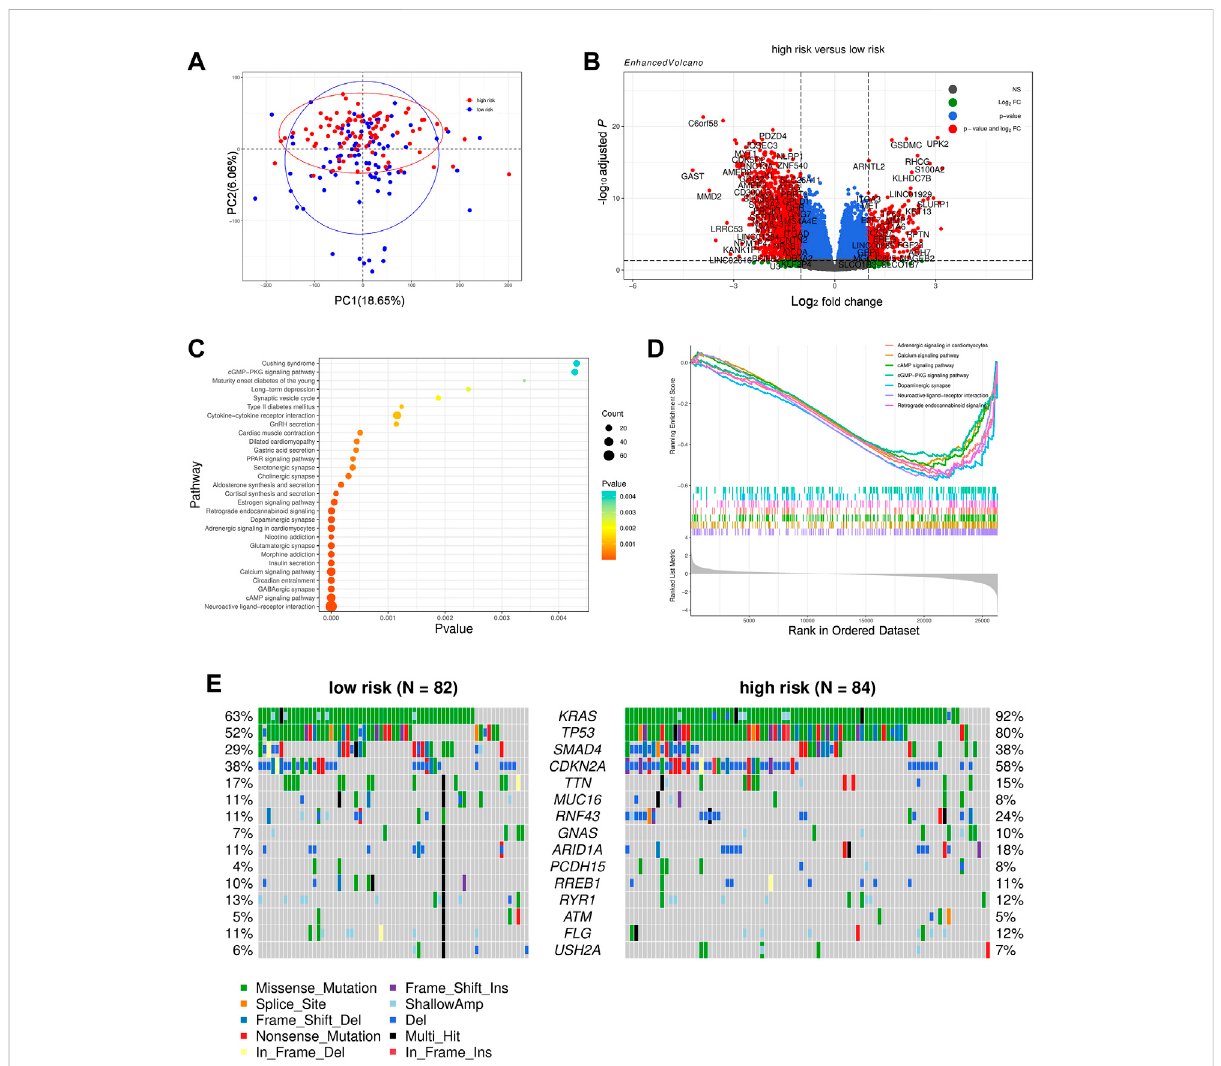
FIGURE 7 ComparisonofthesubgroupsofTCGAcohort. (A) PrincipalcomponentanalysisoftheTCGAcohortgroupedbyhighandlowrisk. (B) Avolcano plot represented DEGs between the high- and low-risk groups of TCGA cohort. (C) Function enrichment analysis of DEGs based on the KEGG signaling pathway. (D) GSEA result of DEGs based upon KEGG signaling pathway. (E) Distribution of frequently mutated genes in different TCGA